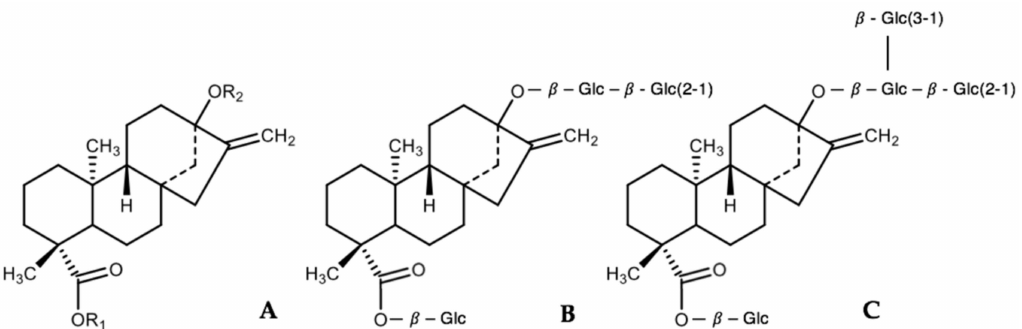
Figure 1. Backbone structure of SGs ( A ), Stevioside ( B ), and Reb A ( C